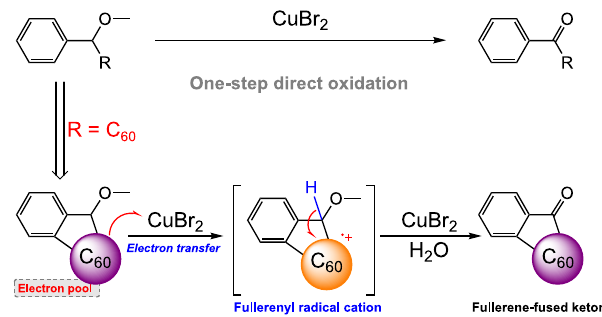
Fig. 1 Working concept. One-step direct oxidation of alkoxy groups to ketones with the fullerene as redox